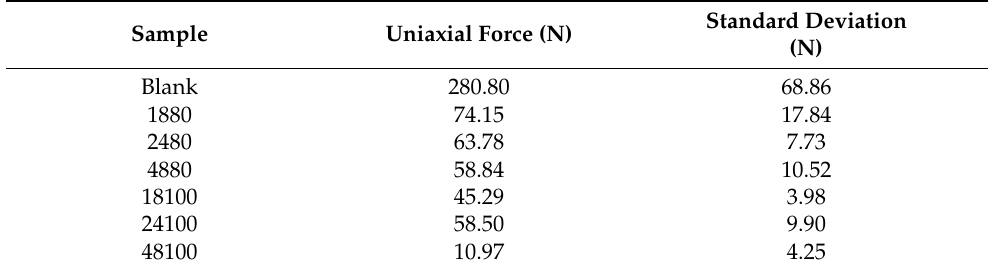
Table 1. Uniaxial force results for all fabric samples and corresponding standard deviation.